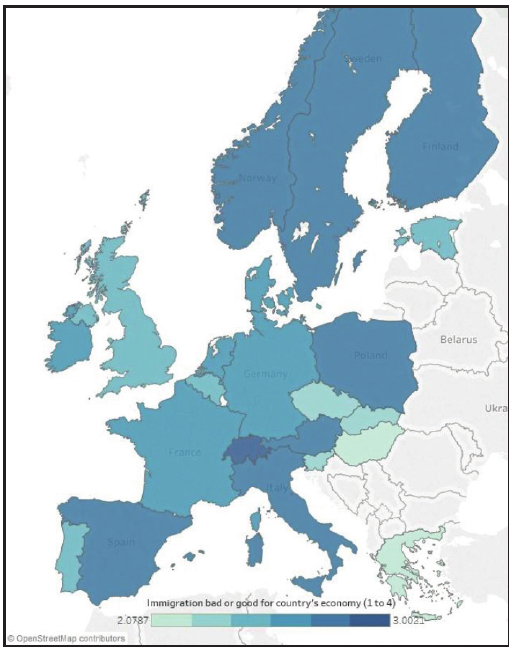
Figure 1 European attitudes toward immigration is bad or good for country’s economy.